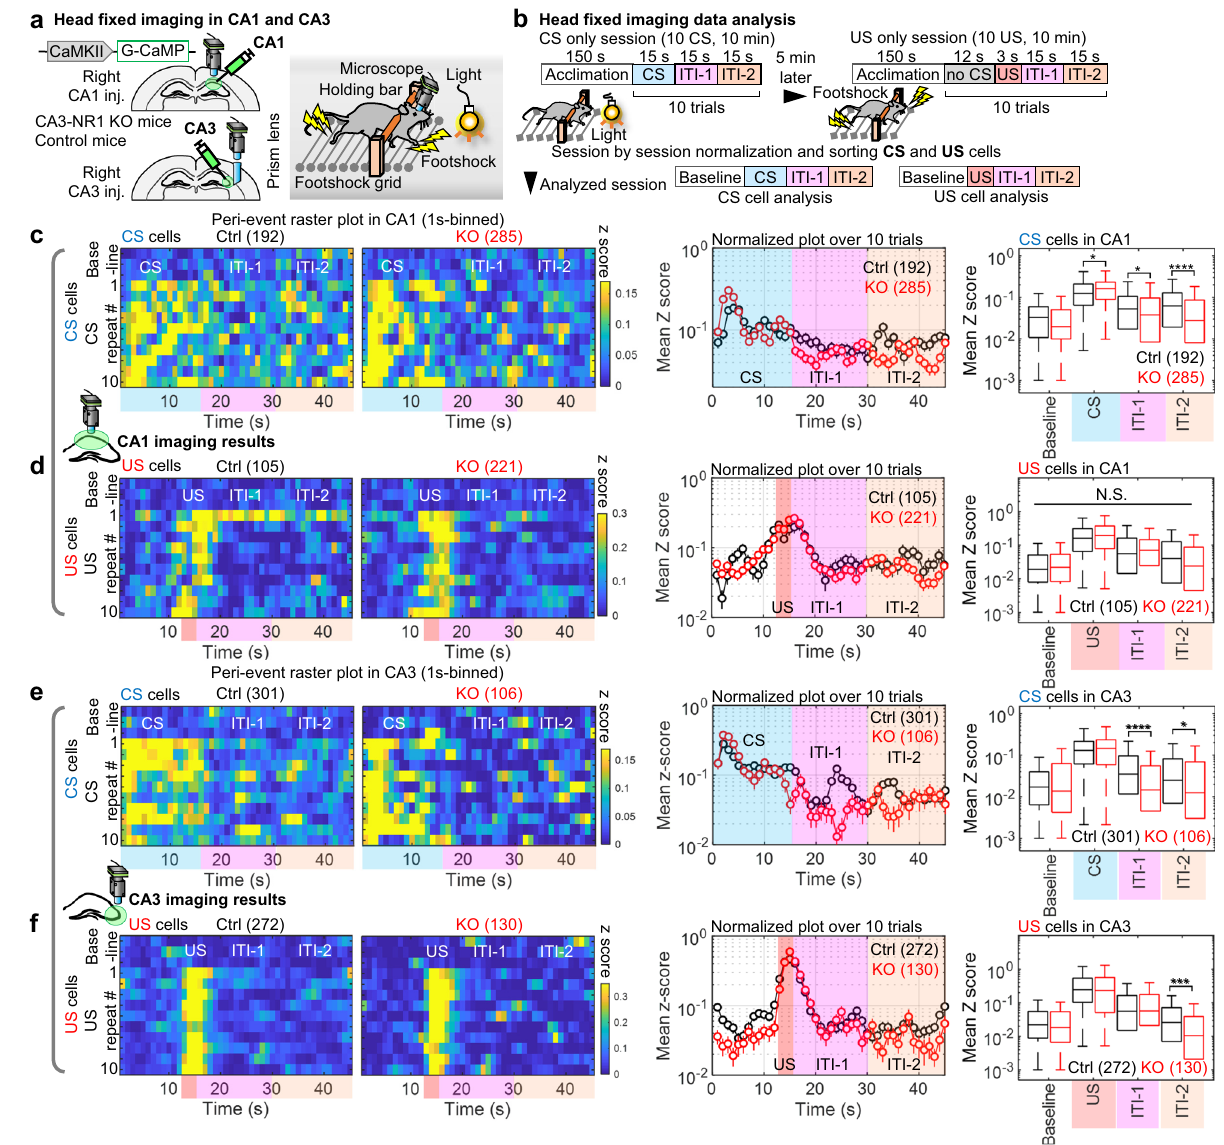
Fig.4|CA3NRs-dependentreverberationbysinglestimuliinthehippocampal networkunderhead- fi xedconditions.a Left,experimentaldesign.Right,schema for head- fi xed imaging. The same footshock grid and light bulb were used in free- moving and head- fi xed imaging experiments. b Imaging data analysis scheme. In each cell, Ca2 + data are classi fi ed into four sessions, and the calculated mean z- score, considered to represent responsiveness, is sorted into CS- and US- responsive subpopulations. c-f Left, peri-event raster plots during single ( c ) CS presentation session in CA1 (two-tailed unpaired Wilcoxon rank sum test for CA1 CS cells: CS, P =0.019; ITI-1, P =0.013; ITI-2, P =0.00001), ( d ) US presentation session in CA1, ( e ) CS presentation session in CA3 (two-tailed unpaired Wilcoxon rank sum test for CA3 CS cells: ITI-1, P =0.00003; ITI-2, P =0.021), and ( f ) US presentation session in CA3 of (left) control and (right) KO mice (two-tailed unpaired Wilcoxon rank sum test for CA3 US cells: ITI-2, P =0.0003). Each short